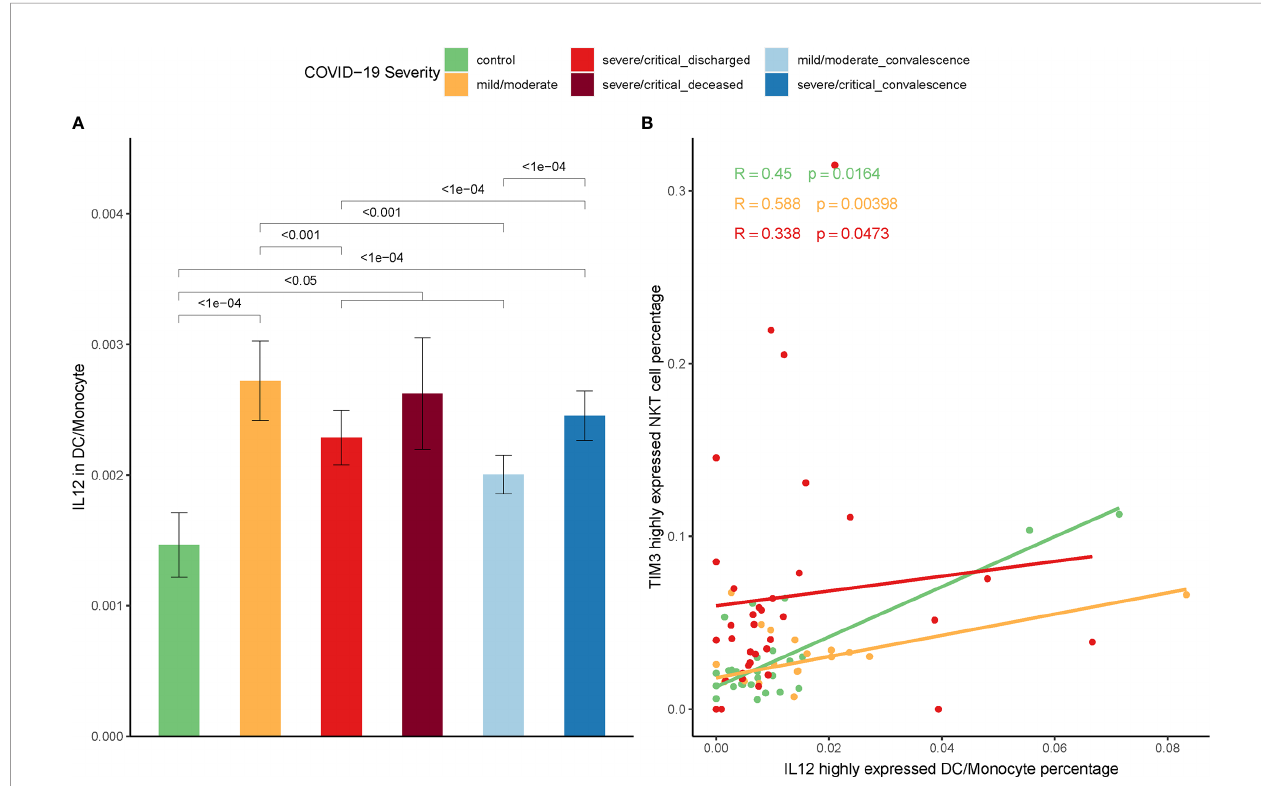
FIGURE 6 | Correlation between IL-12 and expression of Tim-3 on NKT cells. (A) Expression of IL-12 on DCs/monocytes in COVID-19 patients and controls. (Wilcoxon test) (B) Correlation between the percentage of IL-12 highly expressed DCs/monocytes and the percentage of Tim-3 highly expressed NKT cells in COVID-19 patients (Spearman correlation coef fi